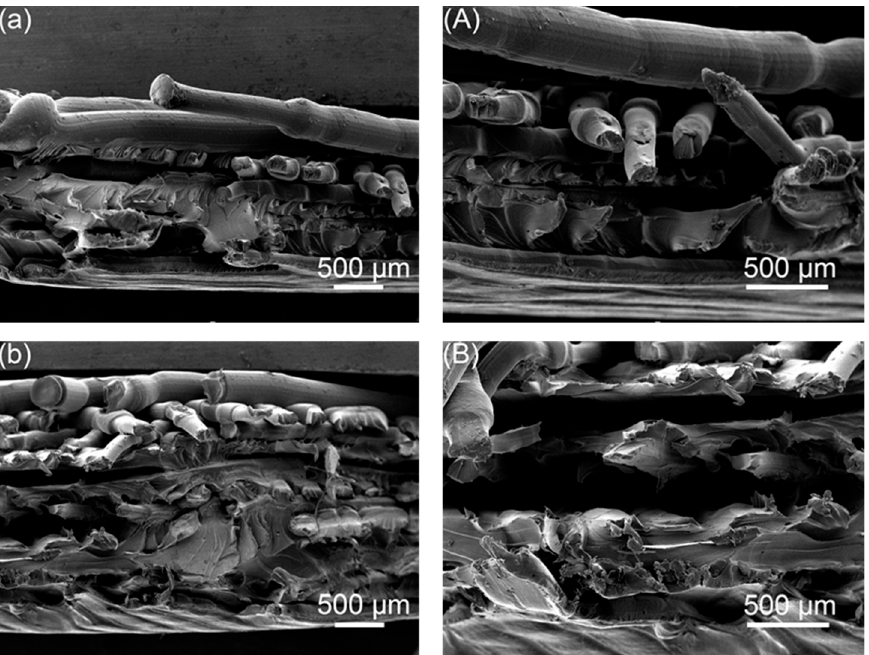
Figure 20. Tensile cross ‐ sectional electron microscope image of the sample, 2 ‐ layer PLA ultrasonic welded part: figure ( a ) 30 times ( A ) 50 times; 3 ‐ layer PLA ultrasonic welded part: ( b ) 30 times ( B ) 50 times. Table 7. Tensile strength and flexural strength of metal ‐ embedded PLA weldments. Sample